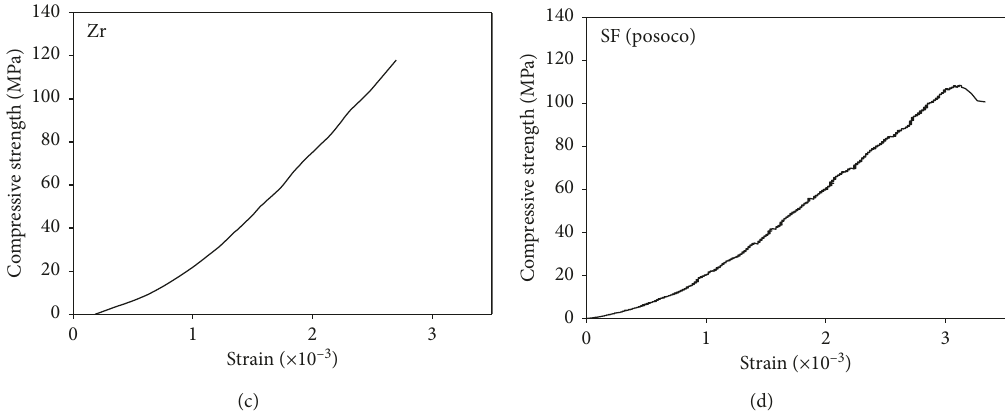
Figure 8: Compression strength-strain graphs. (a) Silica fume. (b) Silica fume and zirconium. (c) Zirconium. (d) Silica fume (posoco).